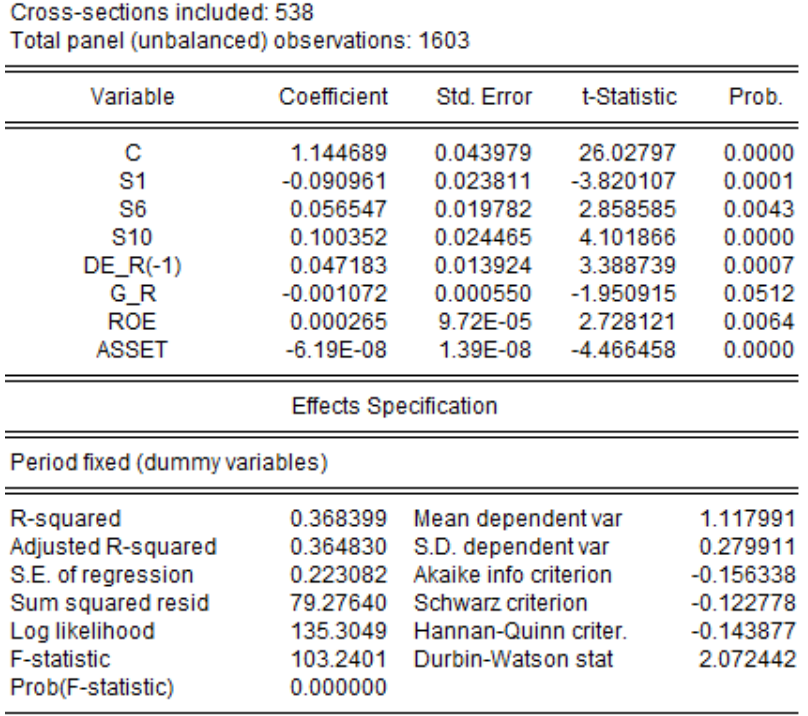
Figure 7. OLS regression estimation (EViews data)